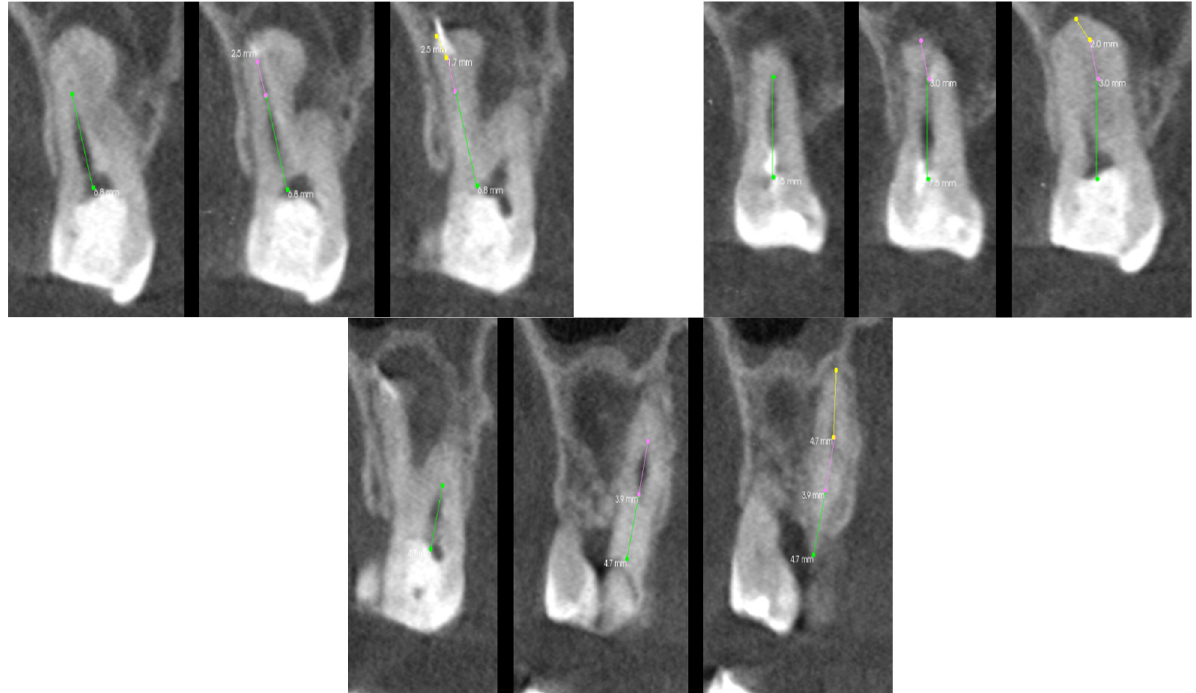
Figure 9. The CT scan of the tooth was used for the analysis of the root canals in the transverse plane, in the case of tooth 16, where the yellow line denotes the axial plane, and the green line denotes the longitudinal plane.